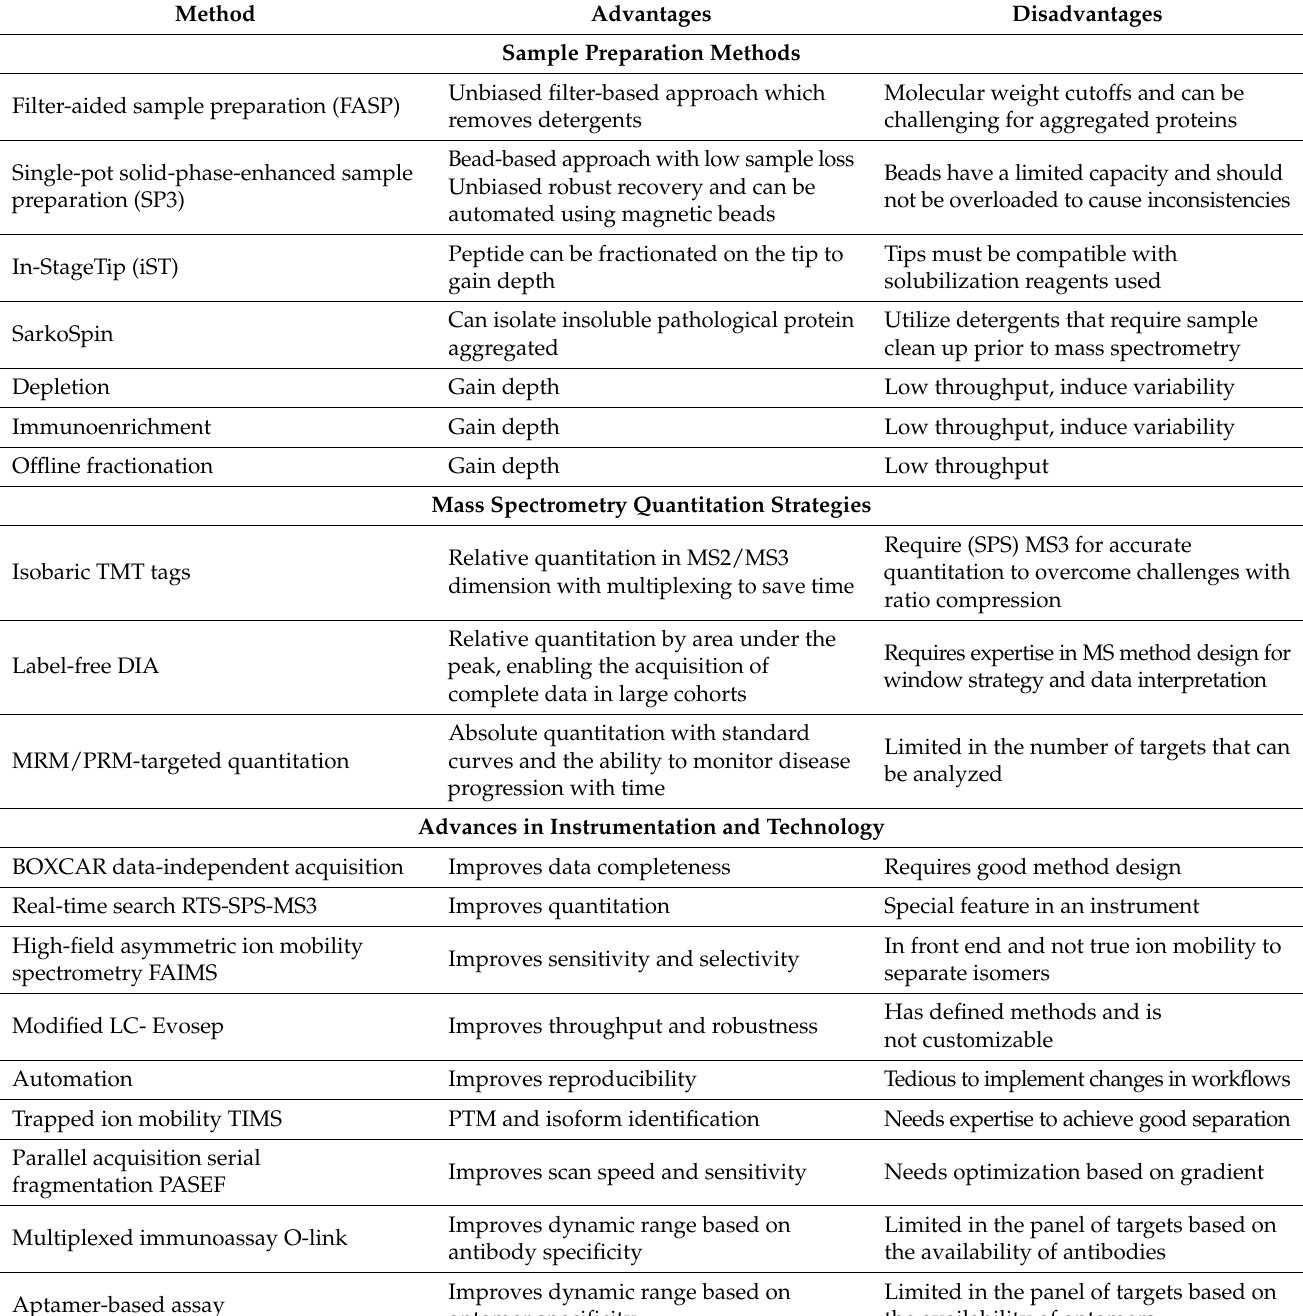
Table 1. Summary of methods used in